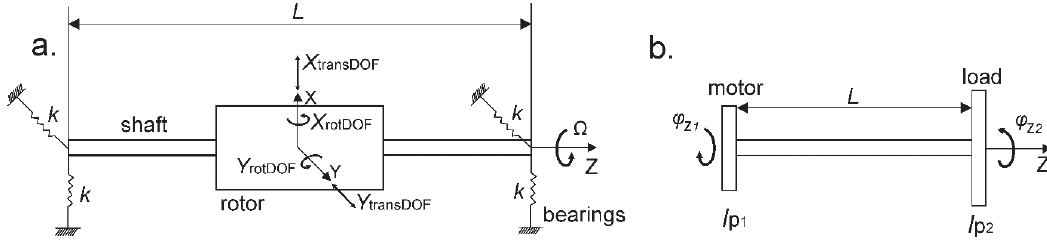
Figure 3. Illustration of: ( a ) a long symmetrical rotor mounted on identical flexible isotropic bearings and ( b ) a two-disc rotor system for torsional vibration study.